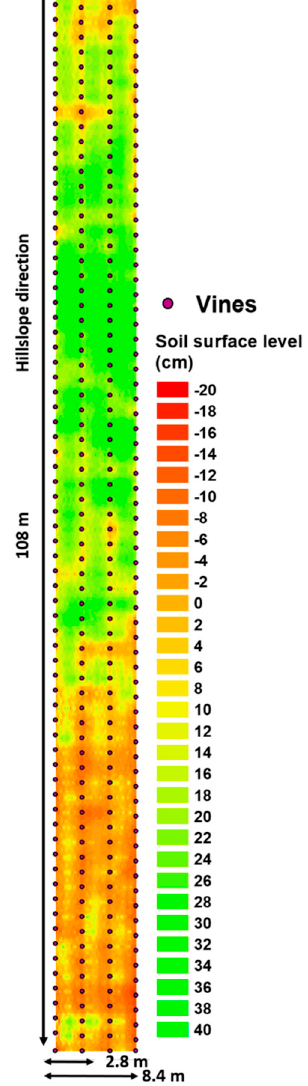
Figure 5. ISUM map showing the current soil surface level.